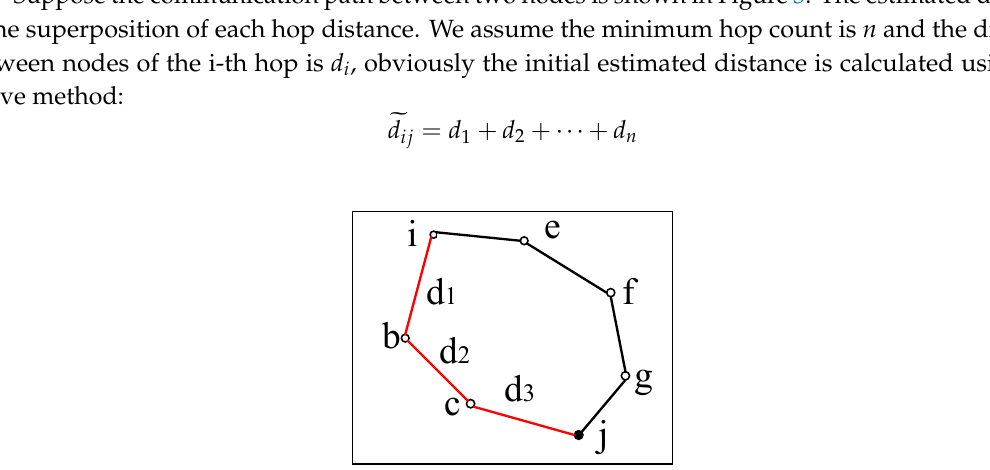
Figure 3. The two broken lines between node i and node j represent two communication paths, the red line represents the shortest path, and d1, d2 and d3 are the distance of each hop . However, the shortest path of communication is not a straight line under most circumstances.